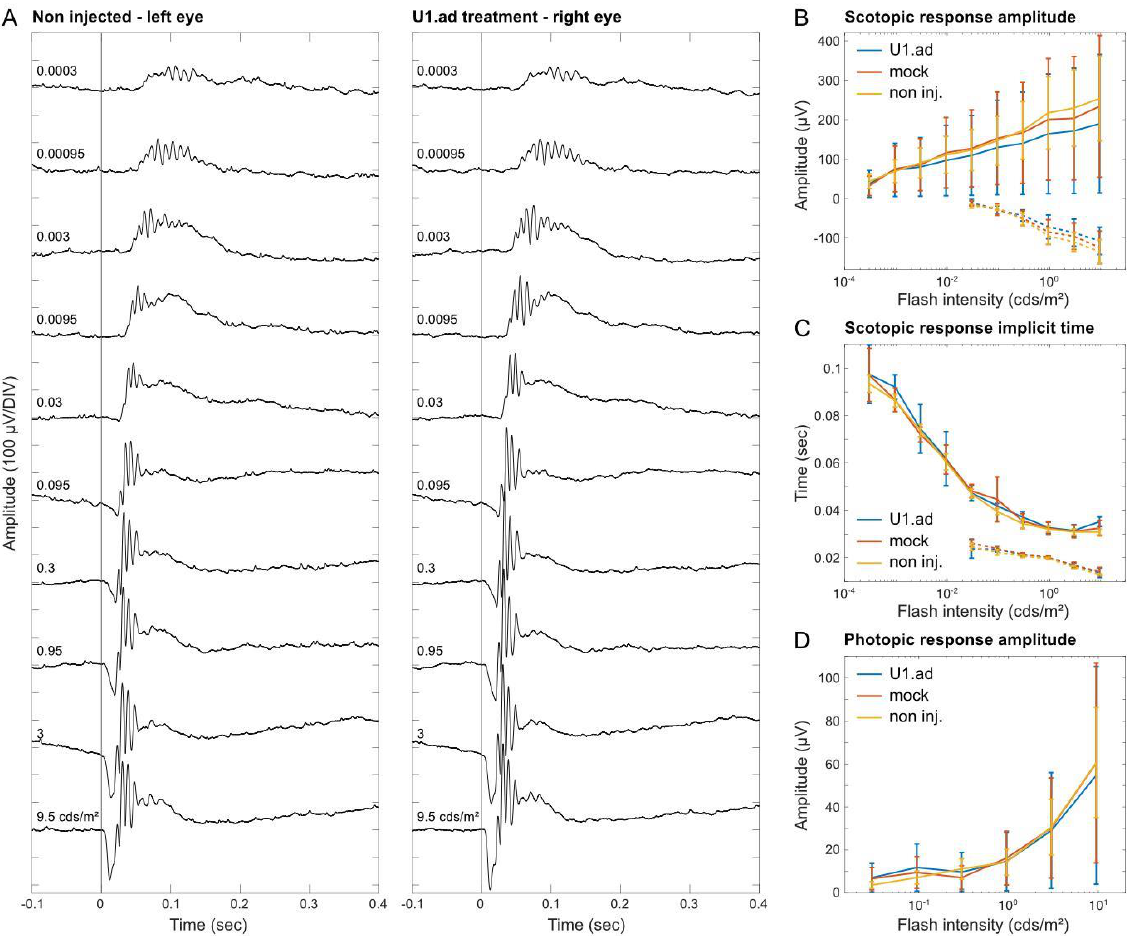
Figure 5. U1-mediated side effects on retinal function were not detected by electroretinography. ( A ) Representative scotopic ERG responses to light flashes of increasing intensity. The left eye was untreated. The right eye was injected with engineered U1 (U1.ad). The ERGs of both eyes were recorded simultaneously. ( B ) Mean scotopic ERG amplitudes. Error bars represent 95% confidence intervals (U1.ad: n = 7, mock: n = 9, non-injected: n = 24). A-wave dashed line, b-wave solid line. ( C ) Scotopic ERG implicit times corresponding to B . ( D ) Photopic ERG amplitudes of light-adapted mice with stimulus flash of increasing intensities corresponding to B .